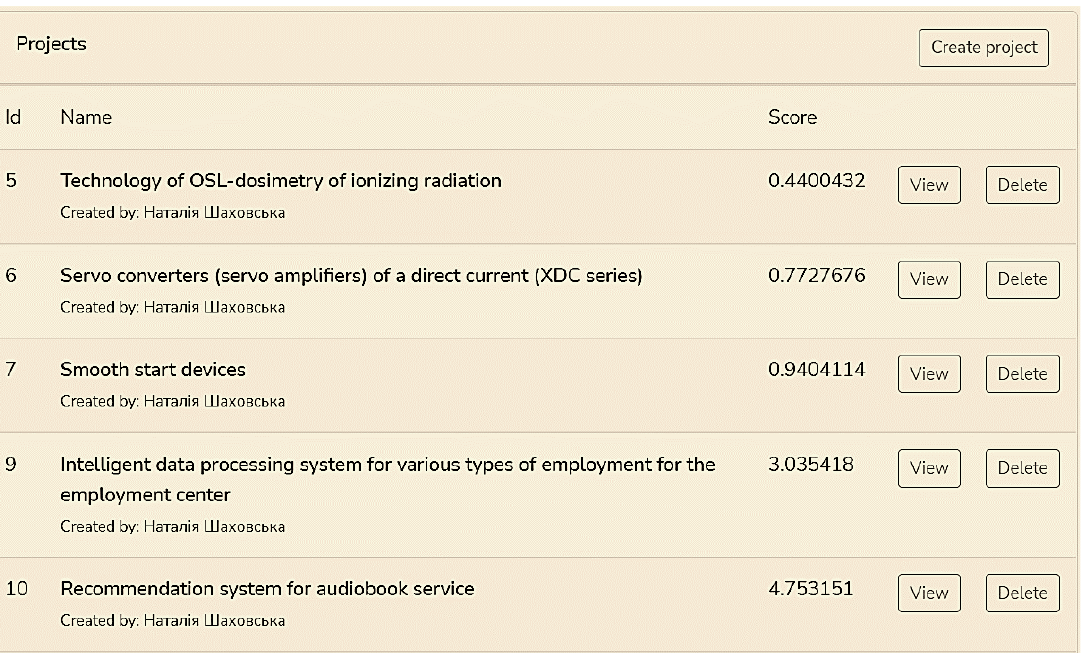
Figure 7. Database schema.